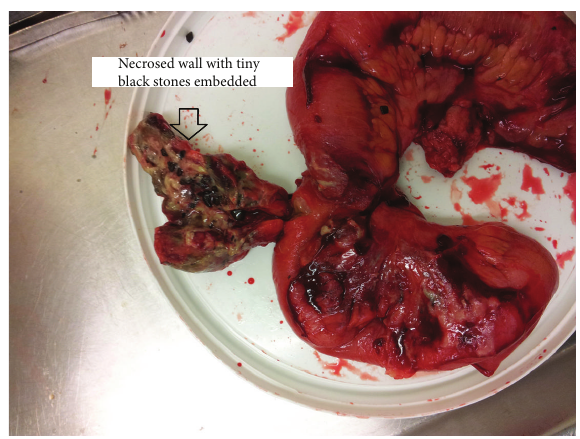
Figure 1: Necrosed Meckel’s diverticulum with multiple stones.